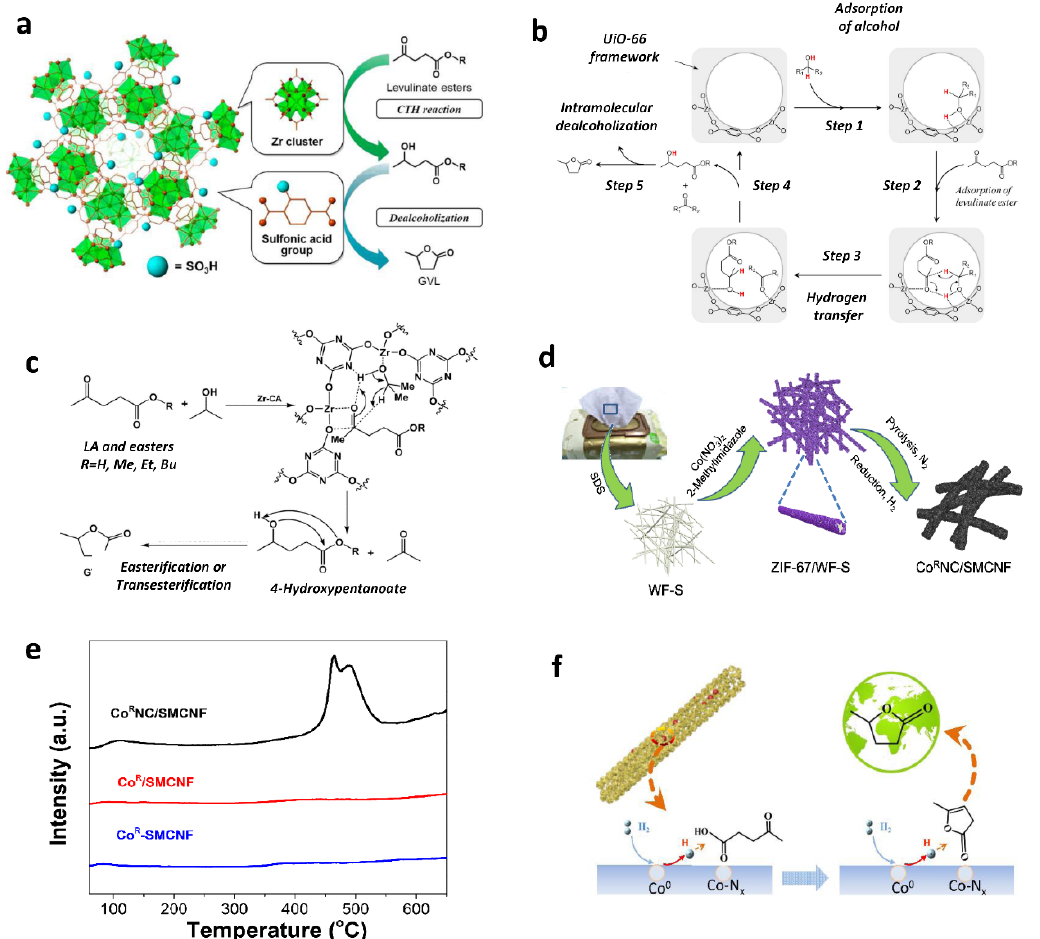
Figure 8. ( a ) Illustration of the structure of sulfonic acid ‐ functionalized UiO ‐ 66 and the reaction pathway for the catalytic transfer hydrogenation (CTH) of LA or levulinate esters to produce GVL. ( b ) A possible reaction mechanism for CTH process of LA or levulinate esters to produce GVL over UiO ‐ 66 ‐ S x catalyst. Reproduced with permission from Reference [67]. Copyright 2017, American Chemical Society. ( c ) A plausible reaction mechanism for the CTH reaction of LA and its esters into GVL catalyzed by Zr–CA. Reproduced with permission from Reference [68]. Copyright 2016, Royal Society of Chemistry. ( d ) Schematic illustration of the synthesis process for Co R NC/SMCNF. ( e ) CO 2 temperature ‐ programmed desorption (CO 2 ‐ TPD) profiles of Co R NC/SMCNF, Co R /SMCNF and CoR–SMCNF. ( f ) Mechanistic model for the hydrogenation of LA to GVL over Co R NC/SMCNF cat ‐ alyst. Reproduced with permission from Reference [70]. Copyright 2020, Elsevier Ltd. 3.3.2. M ‐ N Active Sites The electronic structure of active sites can greatly be tailored via N ‐ functionalization [71]. The pyrolysis of N–containing MOFs is an effective strategy for N ‐ doping. In addi ‐ tion, unique morphology and abundant pores can be created upon MOFs that are pyro ‐ lyzed. Gong et al. [34] reported that Co ‐ 900 with Co–N x active sites is highly active in the selective hydrogenation of various biomass ‐ derived organic compounds, and 83% LA conversion and 96% GVL selectivity were observed under 2 MPa H 2 at 25 °C for 24 h (Table 3, entry 4). Comparatively, Co–N x free Co nanoparticle (NP) catalysts prove to be less ac ‐ tive, delivering the LA conversion lower than 20% (Table 3, entries 5–7). These results demonstrate that Co–N x is responsible for enhanced hydrogenation performance. Shao et al. [71] designed evenly dispersed Co NPs in N ‐ doped mesoporous carbon nanofibers (MCNF) as efficient catalysts for aqueous LA hydrogenation. An N ‐ rich Co zeolitic imid ‐ azolate framework (ZIF ‐ 67) was anchored on the sodium dodecyl sulfate ‐ modified wipe